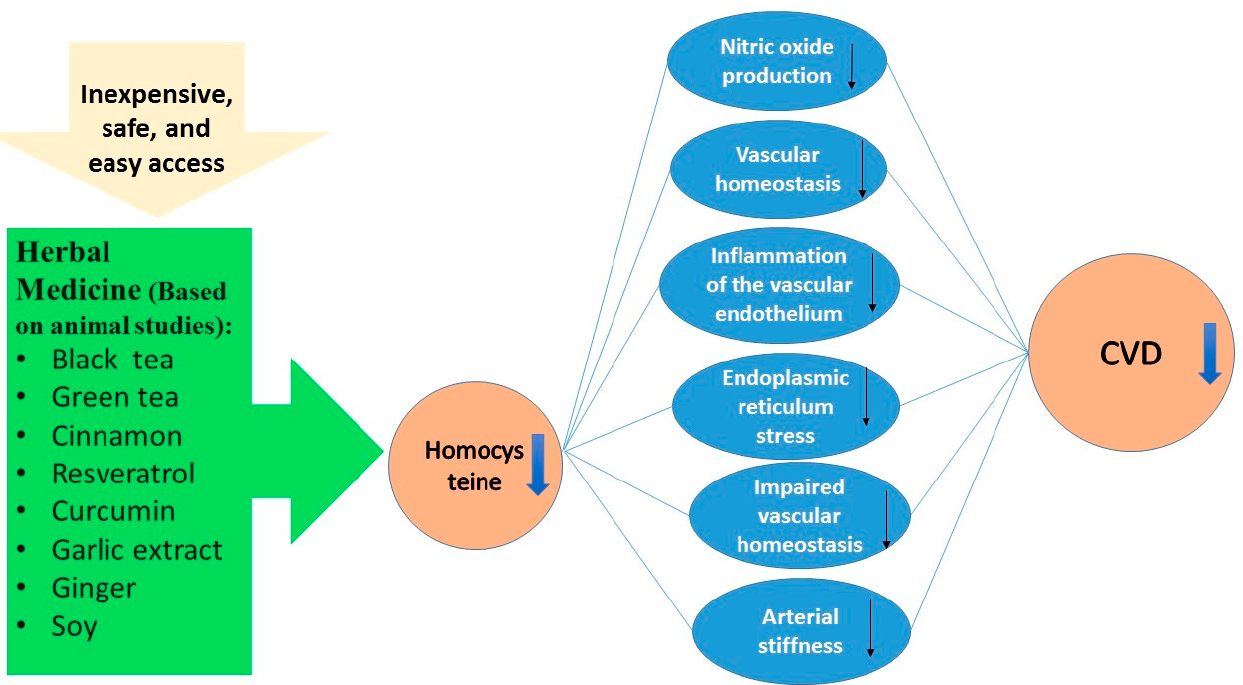
Figure 1. A schematic summary of pathways depicting the beneficial effects of herbal medicine on serum homocysteine (based on animal studies) and the possible mechanisms occurred after reduction in homocysteine level resulted in favorable outcomes; reduction in cardiovascular diseases (CVD).